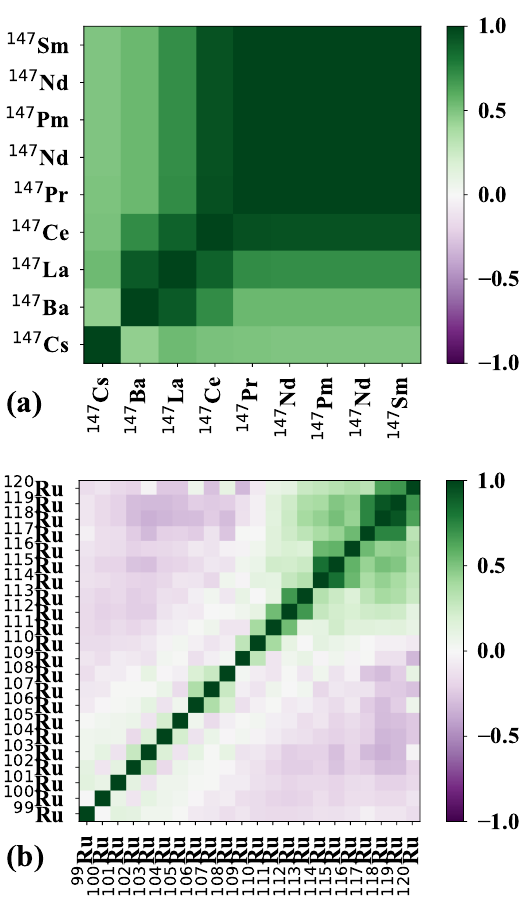
Figure 5. Correlations between isotopes of the (a) A = 147 mass chain and (b) Z = 44 isotopic chain for 252 Cf(sf) using the fit to experimental data from